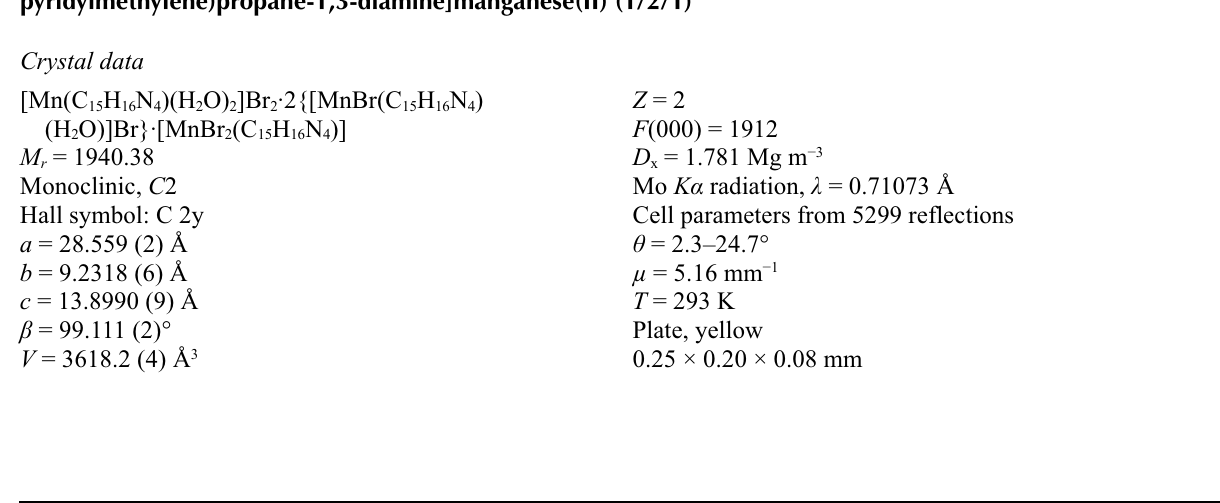
Figure 2 View of the unit-cell contents of the title compound. Hydrogen-bond interactions are drawn with dashed lines. Diaqua[ N , N ′ -bis(2-pyridylmethylene)propane-1,3-diamine]manganese(II) dibromide–aquabromido[ N , N ′ -bis(2- pyridylmethylene)propane-1,3-diamine]manganese(II) bromide–dibromido[ N , N ′